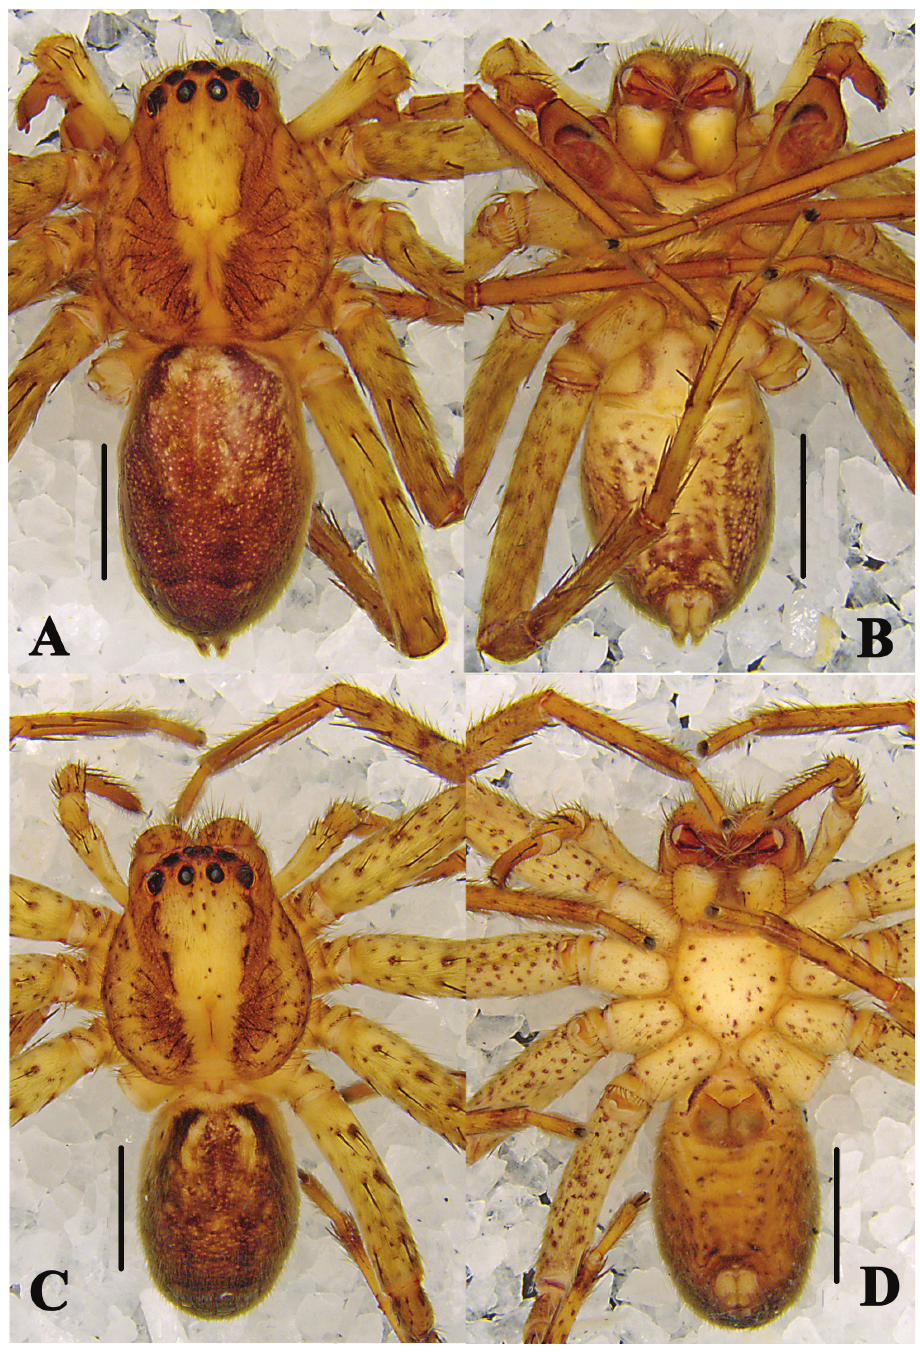
Figure 4. Pseudopoda bibulba Xu & Yin, 2000 A, B male habitus ( A dorsal B ventral) C, D female habitus ( C dorsal D ventral). Scale bars: 2